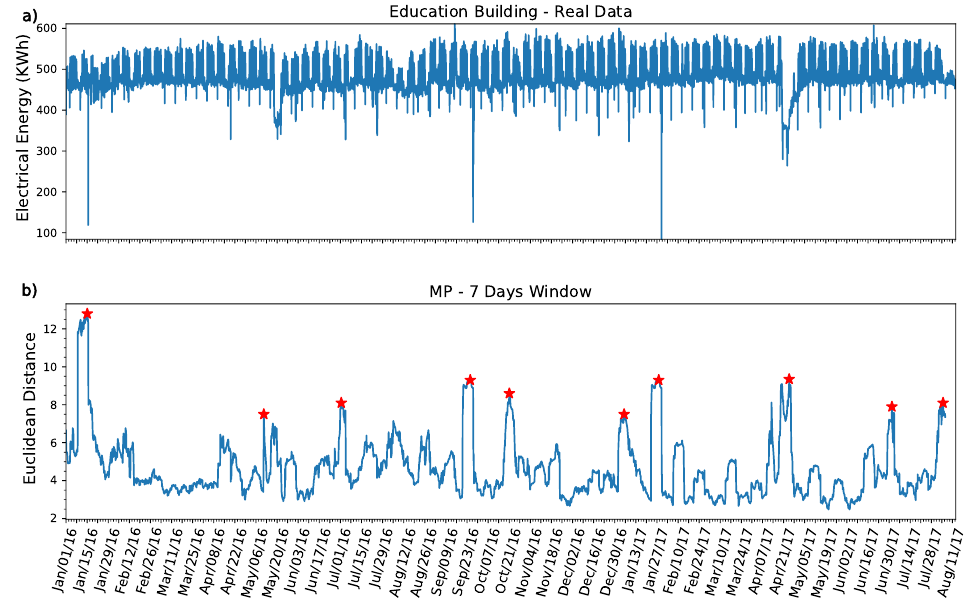
Figure 4. ( a ) Education building load pattern; ( b ) Matrix Profile with top 10